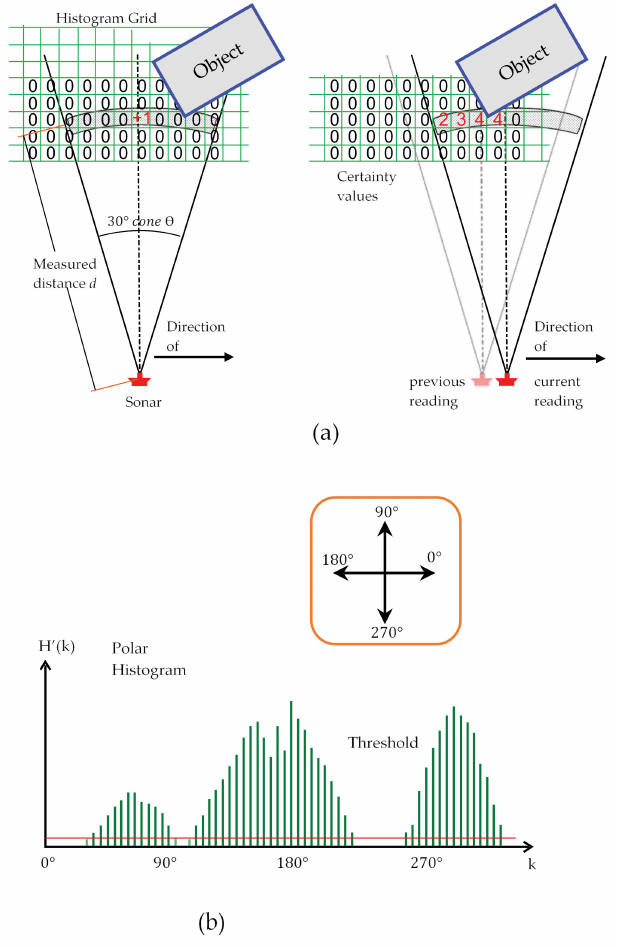
Figure 13. ( a ) 2D histogram grid map; ( b ) converted 1D polar histogram